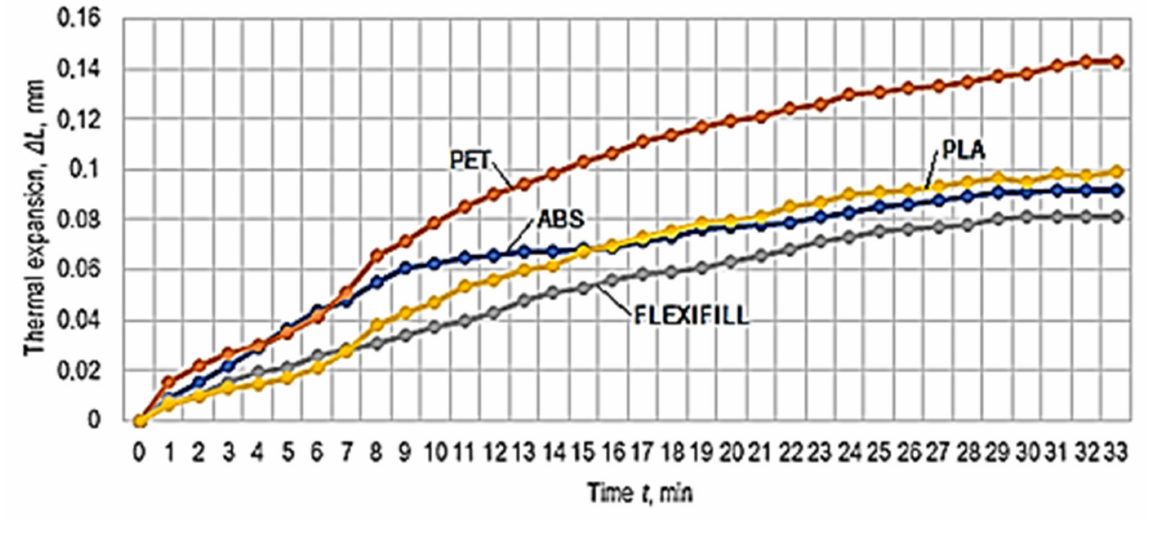
Figure 4. The evolution of thermal expansion over time, with small differences between the initial temperatures.